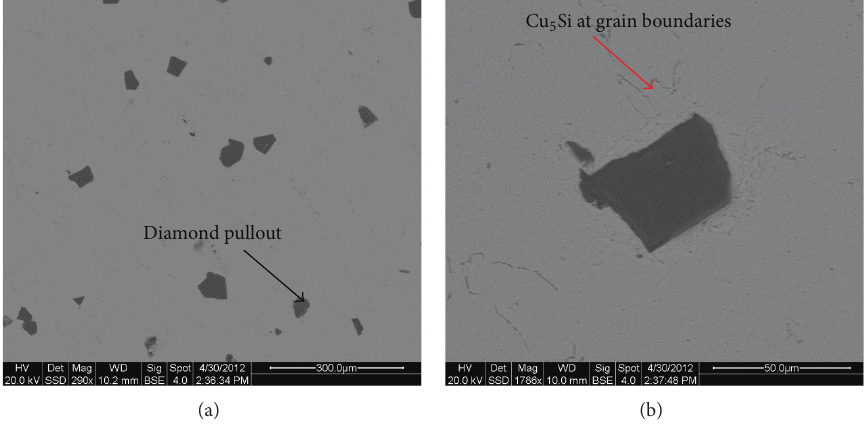
Figure 8: (a) Low and (b) high magnification SEM images of Cu-10wt.% Cu 5 Si-10% Dia samples.